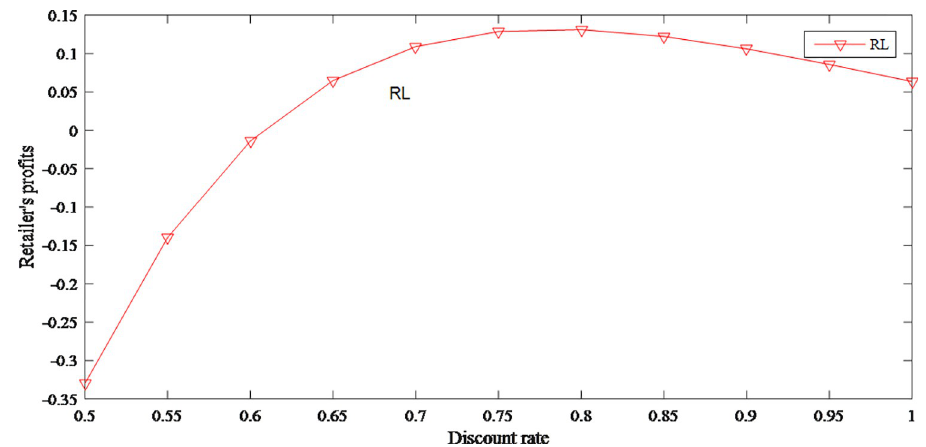
Fig 23. The impact of discount rate on retailer’s profits.